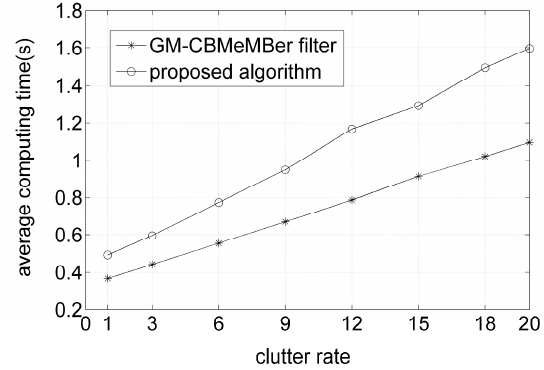
Figure 6. Average computing time for different algorithms versus clutter rate.